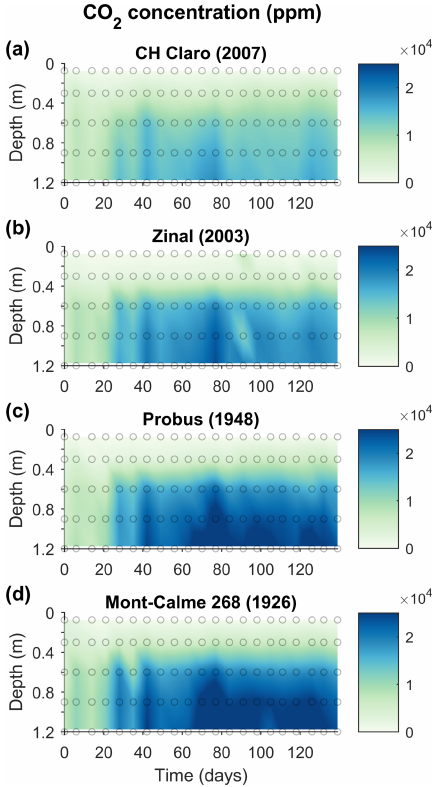
Figure 5. Changes in the CO 2 concentration (ppm) in the lysimeters throughout the experiment for the four wheat cultivars. The average CO 2 concentration of three replicates are shown ( n = 3). Dots indi- cate the measured data points.